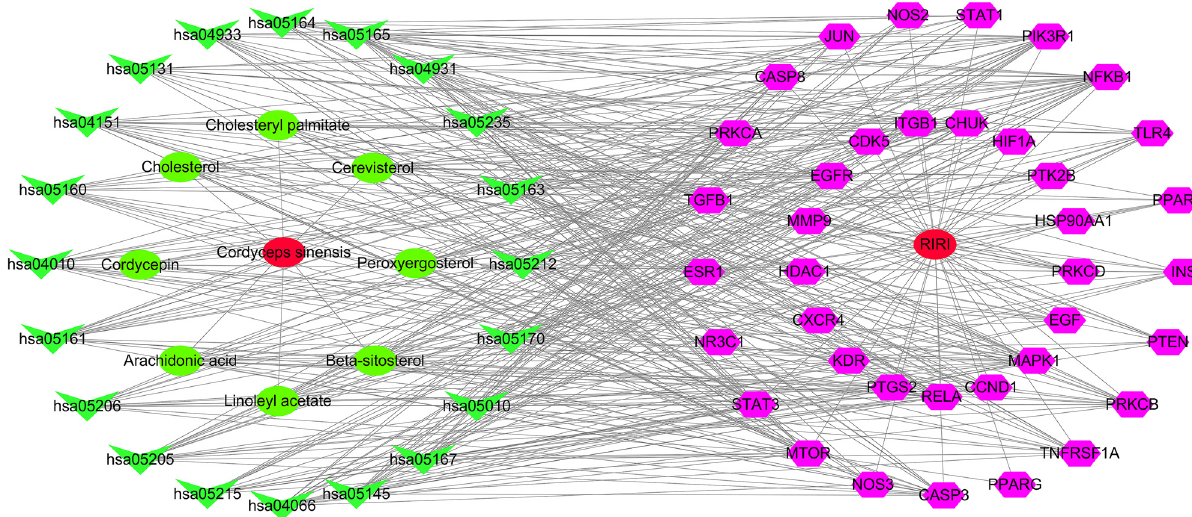
Figure 7: Active component – target – pathway network. The green ellipse, rose red hexagons, and green triangles represent the active com - ponents, core targets, and pathways, respectively. The red ellipses mean C. sinensis and RIRI. The interactions were connected by